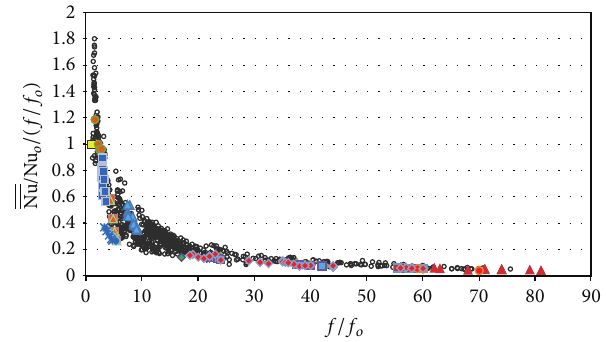
Figure 21: Schematic diagram illustrating typical channel arrange- ment and orientation relative to rotational motion, including result- ing secondary flows [50].